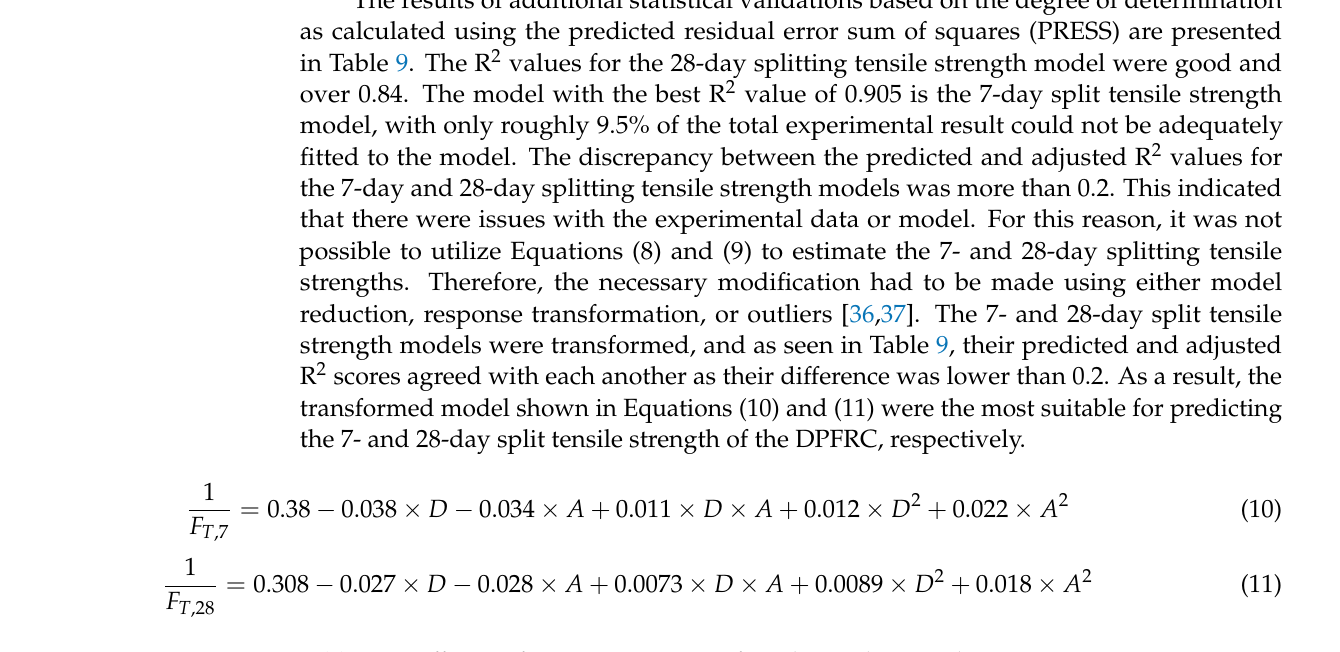
Table 9. Co-efficient of Regression ANOVA for split tensile strength.